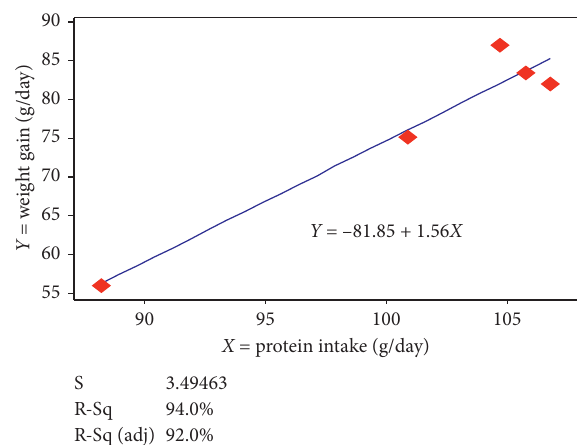
Figure 3: Linear regression relationship of daily body weight gain and protein intake of growing Bonga lambs fed on Rhodes grass hay basal diet and supplemented with dried mulberry and Vernonia mixed leaves’ meal as a substitute to noug seed cake at different